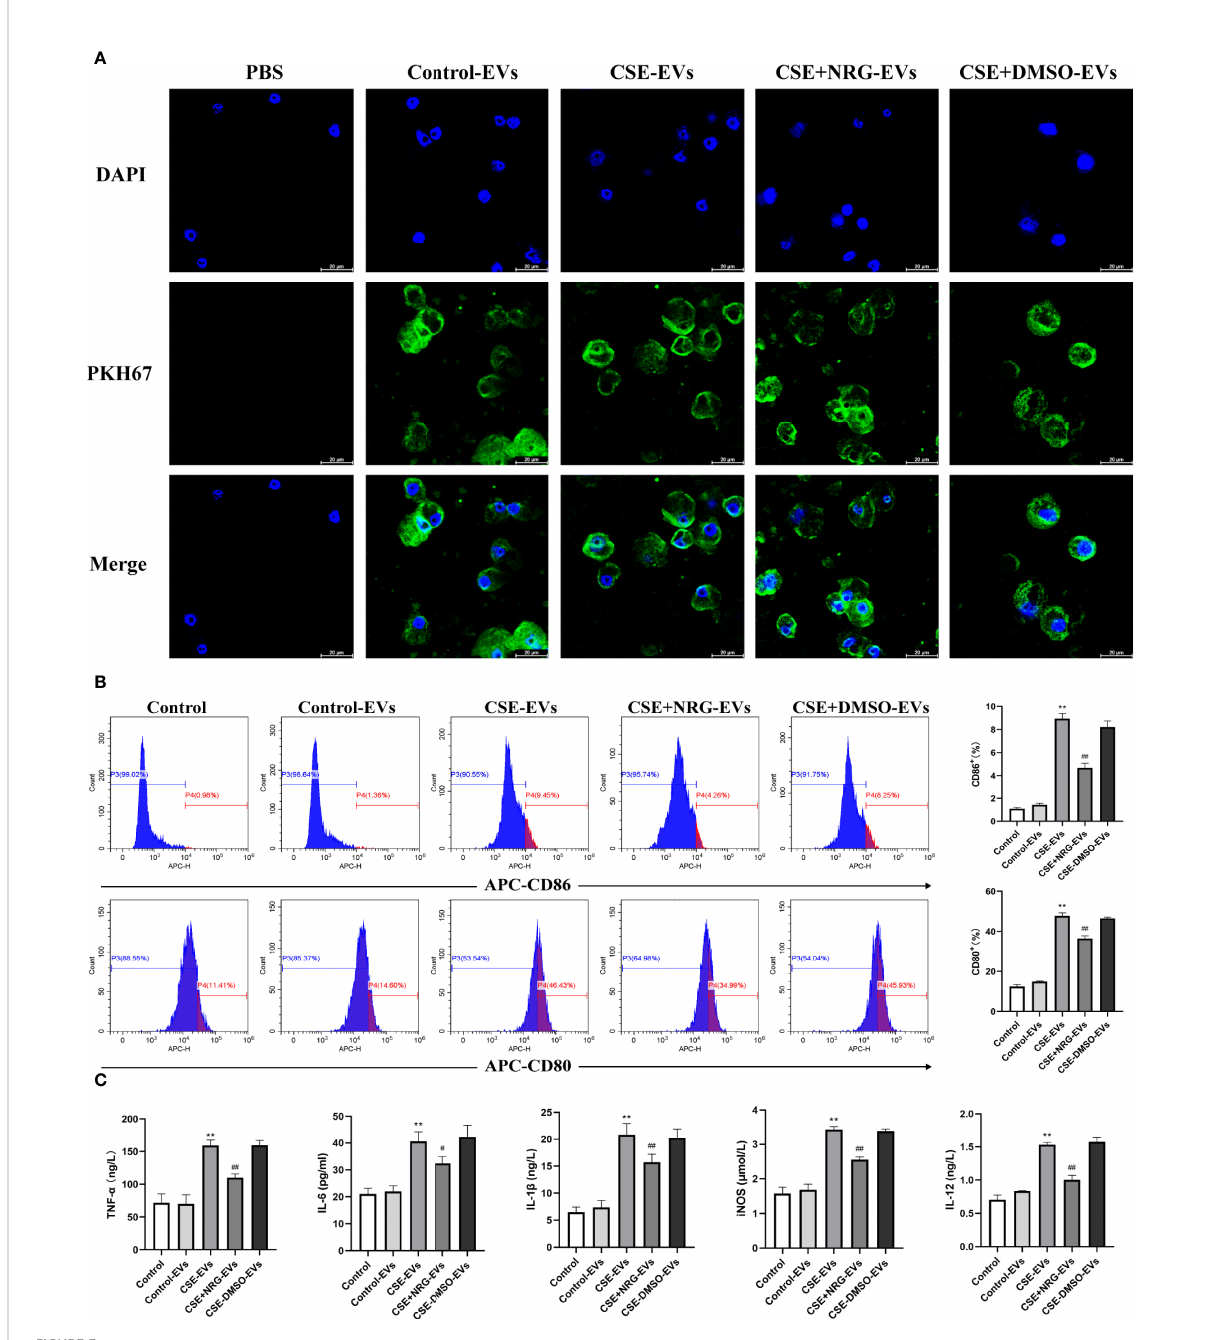
FIGURE 3 CSE+NRG-EVs inhibited M1 macrophage polarization of RAW264.7 macrophages induced by CSE-EVs. (A) Confocal microscopy imaging revealed the uptake of PKH67-labeled EVs by RAW264.7 macrophages. Scale bar = 20 m m. (B) Flow cytometry analysis of M1 macrophages (CD86 + and CD80 + ) population in RAW264.7 macrophages treated with EVs (n = 3). (C) ELISA was performed to evaluate the secretion of M1-associated cytokines including tumor necrosis factor (TNF)- a , interleukin (IL)-6, IL-1 b , inducible nitric oxide synthase (iNOS), and IL-12 of RAW264.7 macrophages (n = 3). ** p <0.01 vs . Control-EVs group. # p <0.05, ## p <0.01 vs . CSE-EVs